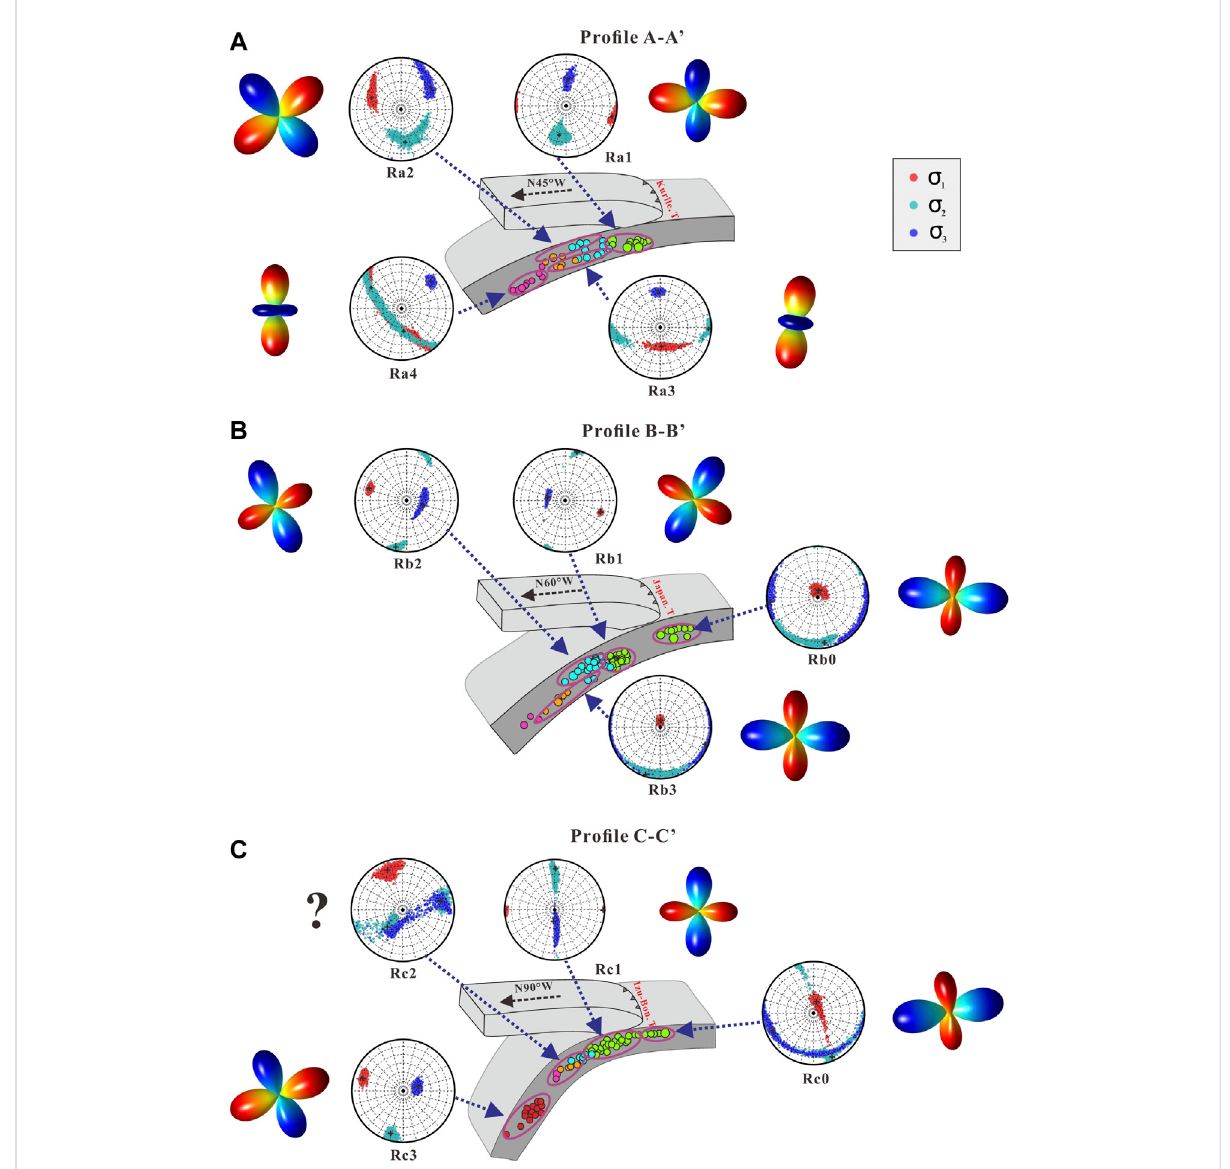
Tectonic cross-sections (not in scale) of all the three pro fi les discussed in this paper (Pro fi le A-A ’ (A) , B-B ’ (B) and C-C ’ (C) ). The dashed black arrowsrepresenttheorientationofthesections,aswellasthedirectionofplatesubduction.Theearthquakesweusedinthispaperisdenotedbythe dots.ThedepthofearthquakesisshownbythecolorbarinFigure1.Respectiveregion-wiseprincipalstressaxeswiththeir95%con fi dencelimitsare plotted on lower hemisphere stereonets, where red: the maximum compressive stress ( σ 1 ), cyan: intermediate principal axis ( σ 2 ) and blue: minimum compressive stress (